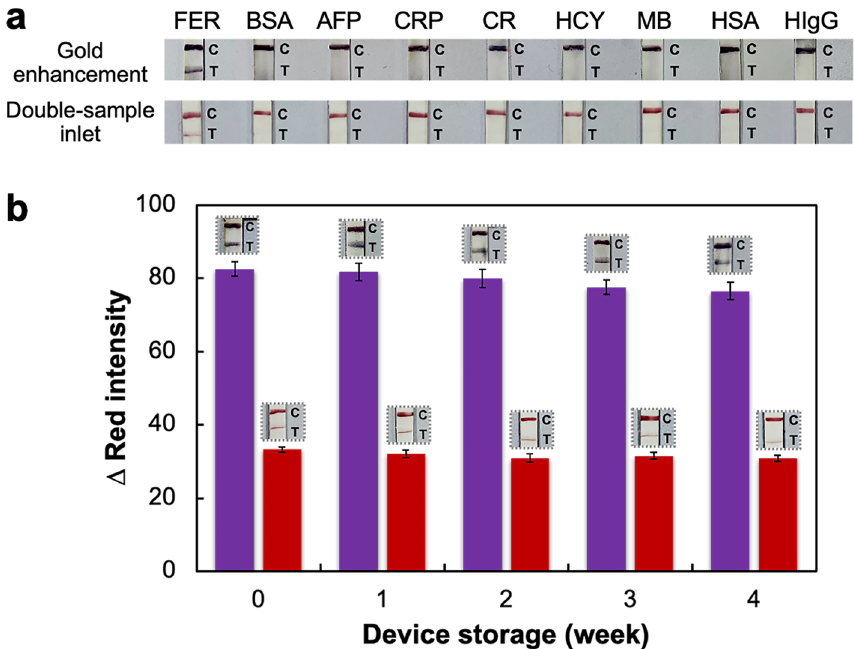
Figure 4. ( a ) Selectivity of the gold enhancement and double-sample inlet devices after the application of 20 ng/ mL of ferritin (FER), 10% (w/v) BSA, 1 µg/mL of alpha-fetoprotein (AFP), c-reactive protein (CRP), creatinine (CR), homocysteine (HCY), myoglobin (MB), human serum albumin (HSA) and human immunoglobulin G (HIgG); ( b ) storage stability of gold enhancement (purple bars) and double-sample inlet (red bars) devices after keeping at RT in a desiccator between 0 and 4 weeks and measuring 20 ng/mL of ferritin (n =